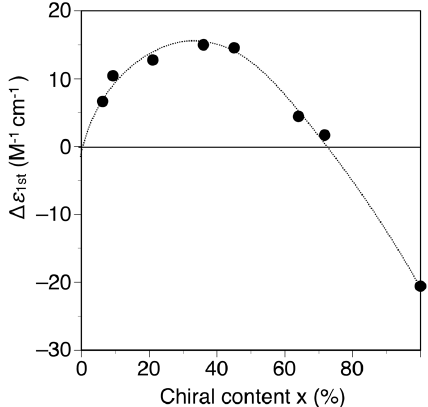
Figure 4. Plots of the Δ ε 1st values of h -poly-( 2 S x - co - 3 1–x ) and h -poly- 2 S in DMF at 25 °C vs. their chiral ( S )- 2 unit contents (x).